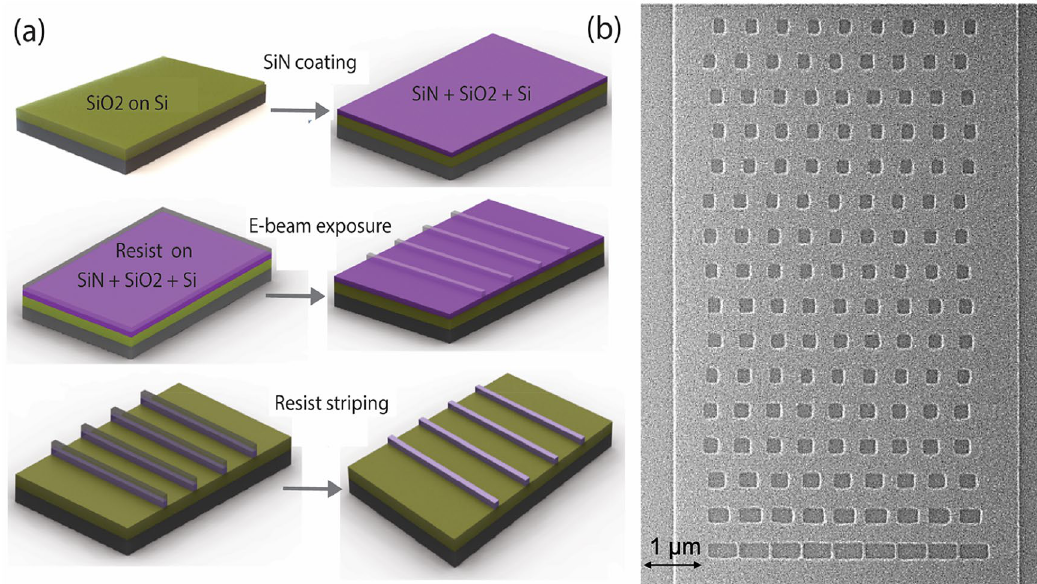
Figure 8. Process flow steps involved in the fabrication of the metasurface (created in Solidworks Standard). ( b ) He ion microscopy of the patterned structure on top of Silicon nitride.